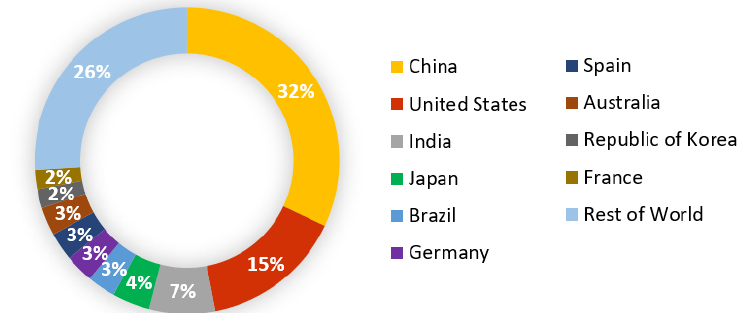
Figure 5. PV panels globally installed in 2021.